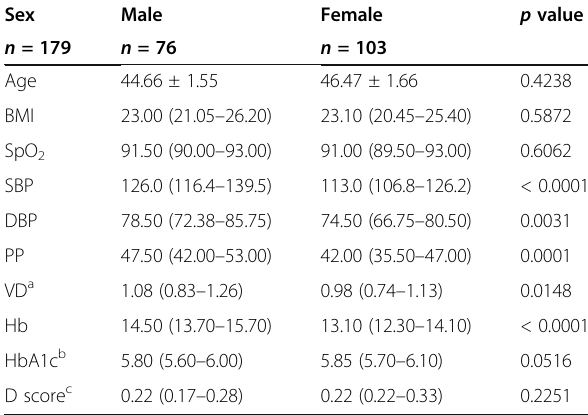
Table 1 Anthropometric variables, biochemical data, and poverty index by sex. Values are presented as the mean ± SE or median (1st quartile – 3rd quartile). Data were analyzed by Student ’ s t test or the Wilcoxon rank-sum test. The D score was considered poor at ≥